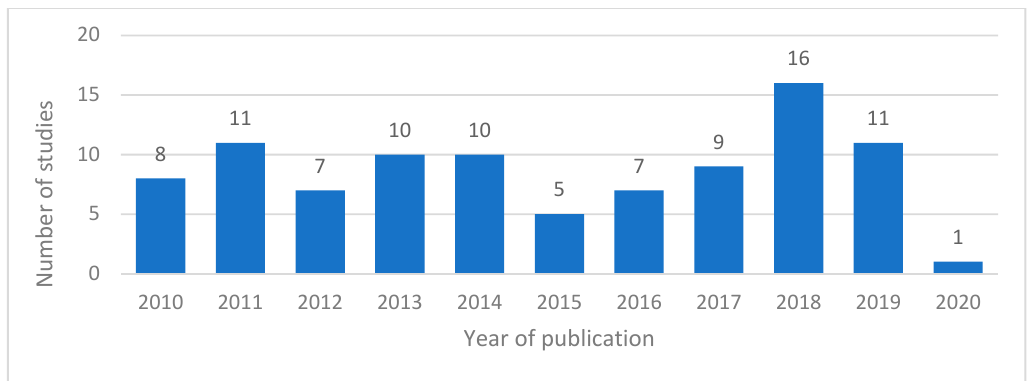
Figure 2. Bar graph showing the number of included studies for each publication year.